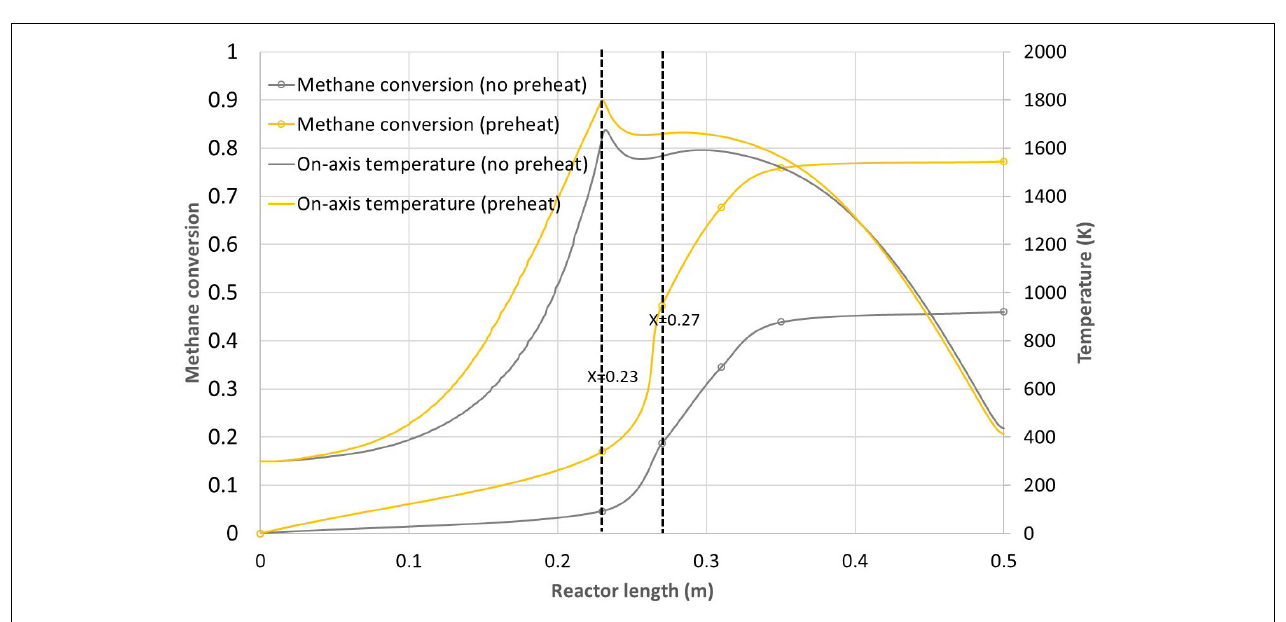
FIGURE 9 | Methane conversion and on-axis temperature vs. reactor length for the 230 mm dual tube configuration and three different methane flow-rates (9.2 × 10 − 6 kg.s − 1 , 4.6 × 10 − 6 kg.s − 1 and 2.3 × 10 − 6 kg.s − 1 ).